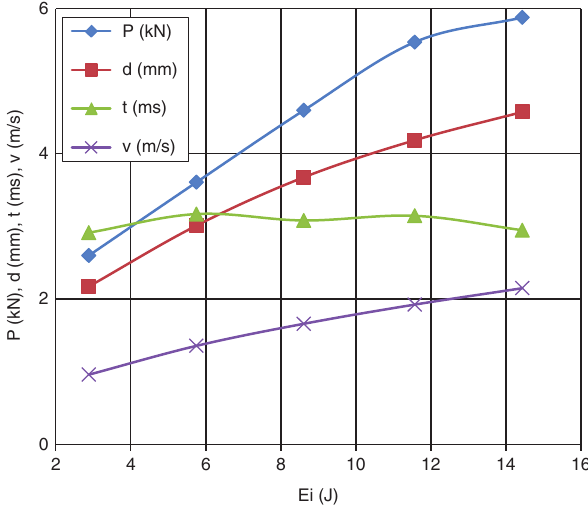
Figure 7 Variation of the maximum load, maximum deflection, contact time, and impact velocity versus impact energy in the com- posite plates of 12 layers.